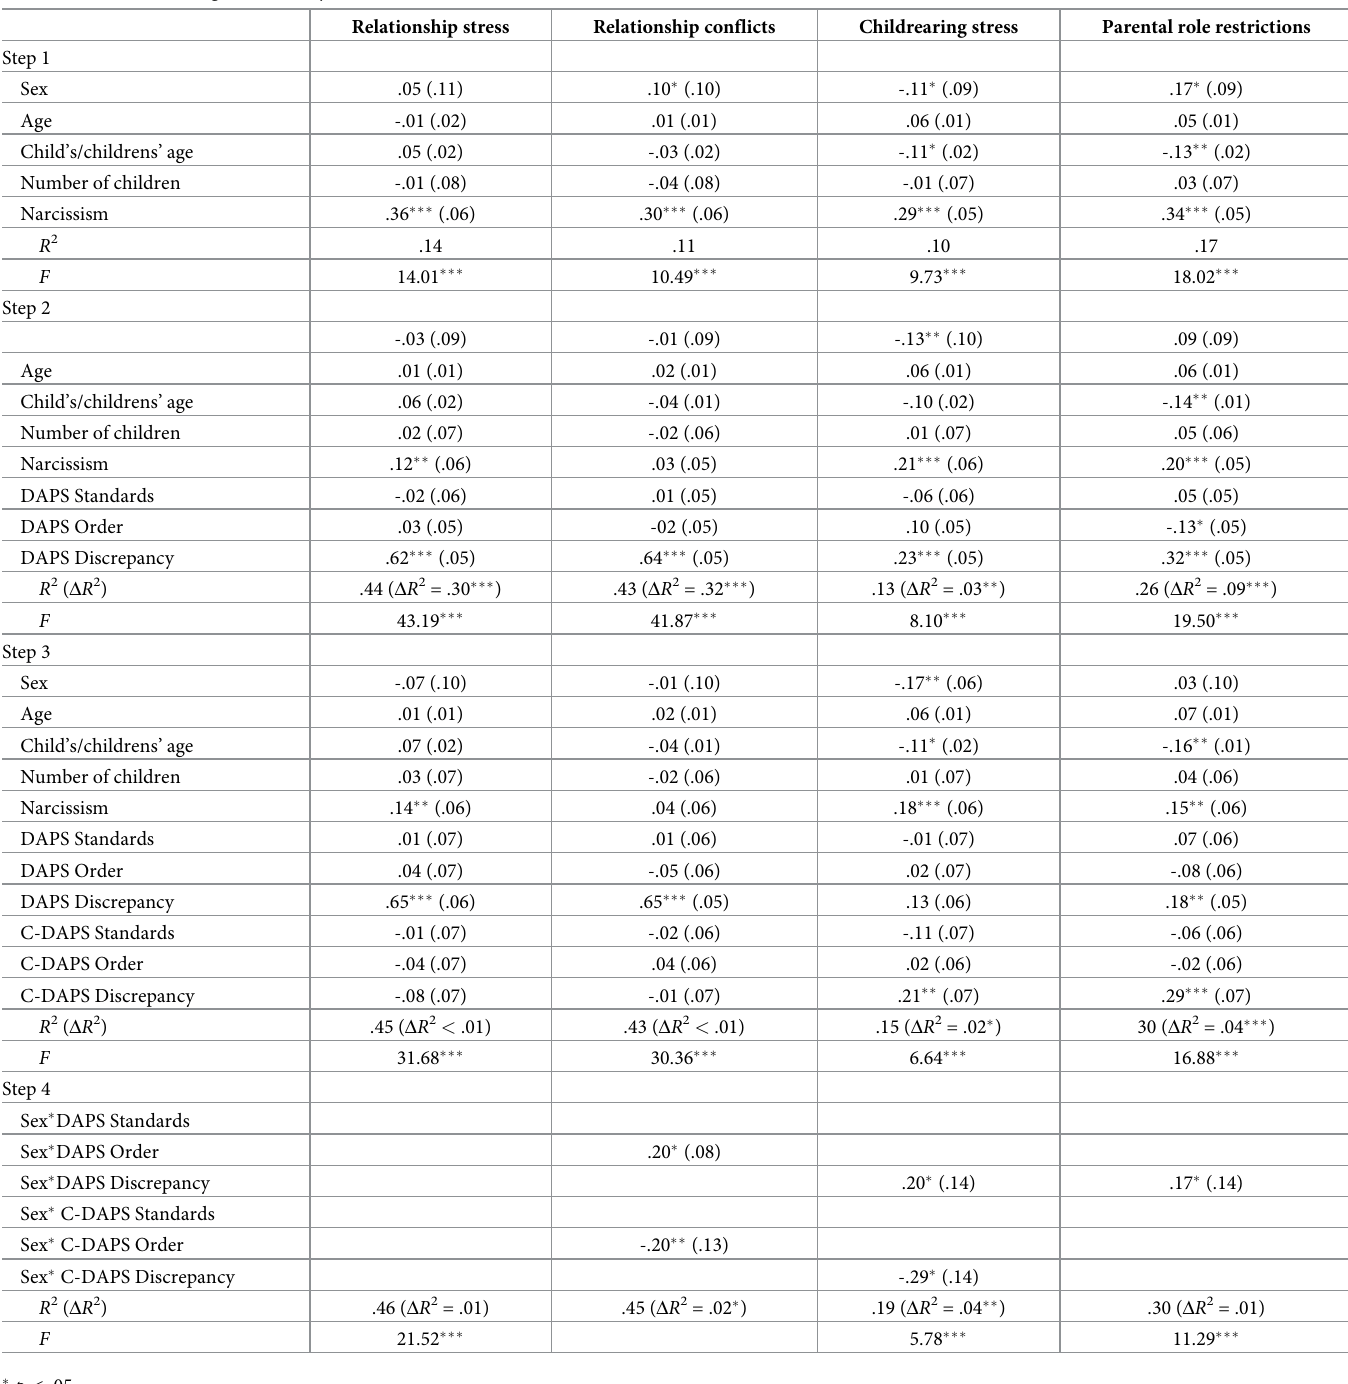
Table 5. The results of regression